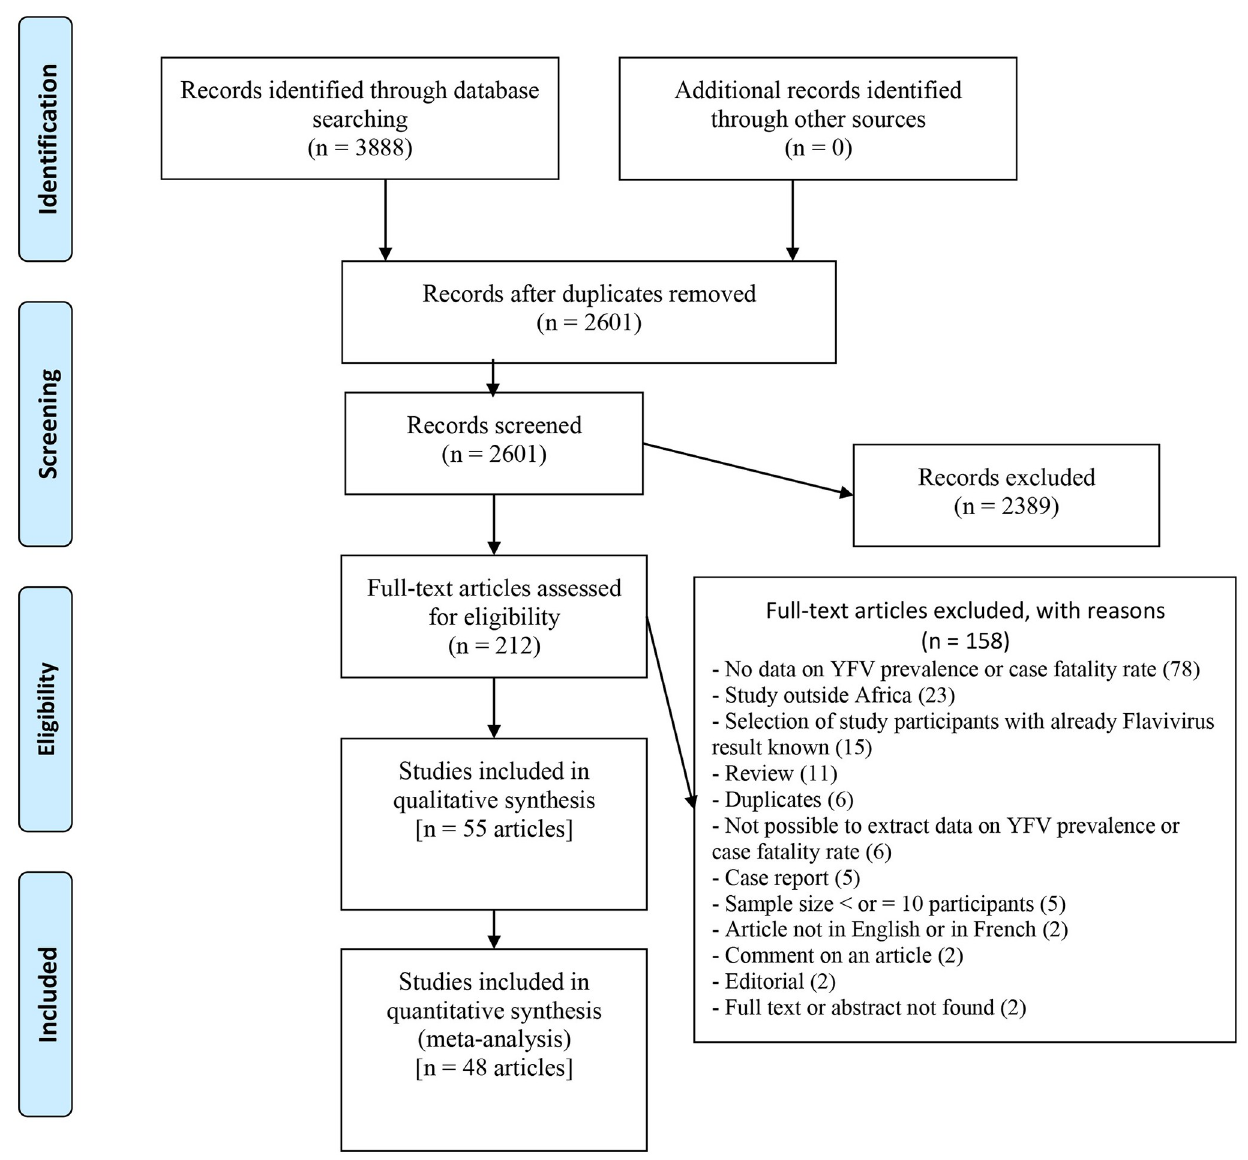
Fig 1. PRISMA flow